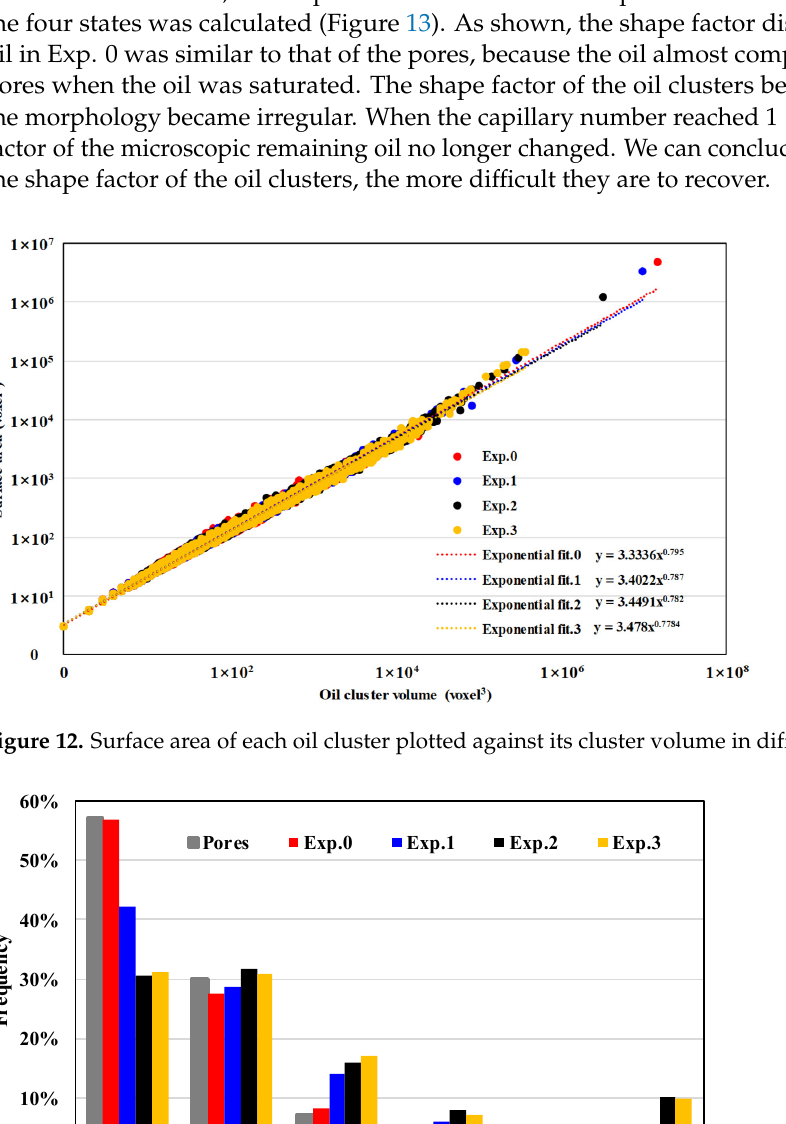
Figure 11. Cumulative contribution of various oil clusters to the overall oil volume in different stages.